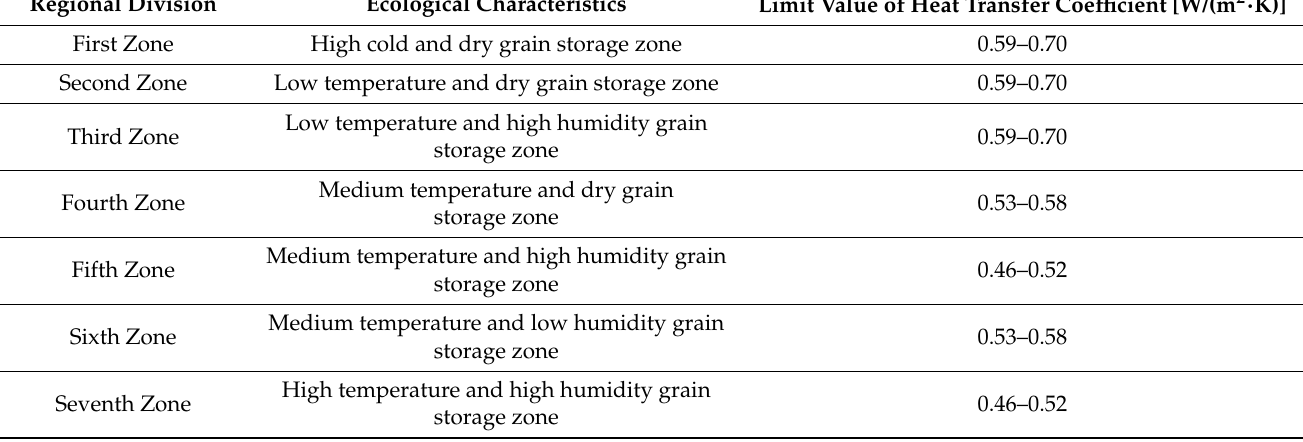
Table 4. Limit values of the heat transfer coefficient of each grain storage ecological zone enclo- sure